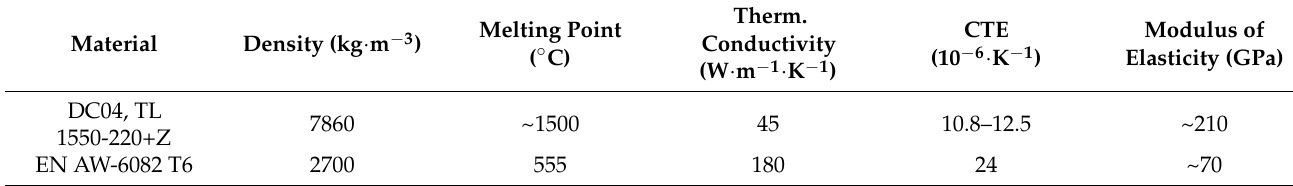
Table 3. Physical properties of the